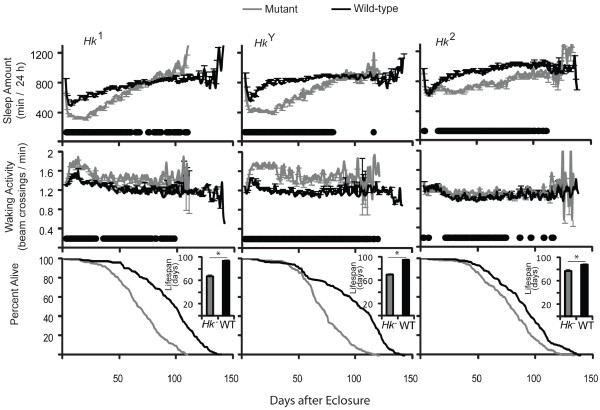
Sleep duration and lifespan are reduced in Hk mutants, while waking activity is increased. Twenty-four hour values of sleep and waking activity from eclosure to death and survival curves in male Hk mutants and wild-type siblings. Inset. Average lifespan. Number of flies: Hk1 = 220; siblings Hk+ = 219; HkY = 226; siblings Hk+ = 231; Hk2 = 199; siblings Hk+ = 216. Black dots and asterisks indicate a significant difference from wild-type (p < 0.05, Mann-Whitney test for sleep analysis; p < 0.0001, log-rank test for lifespan analysis). Values are mean ± SEM.